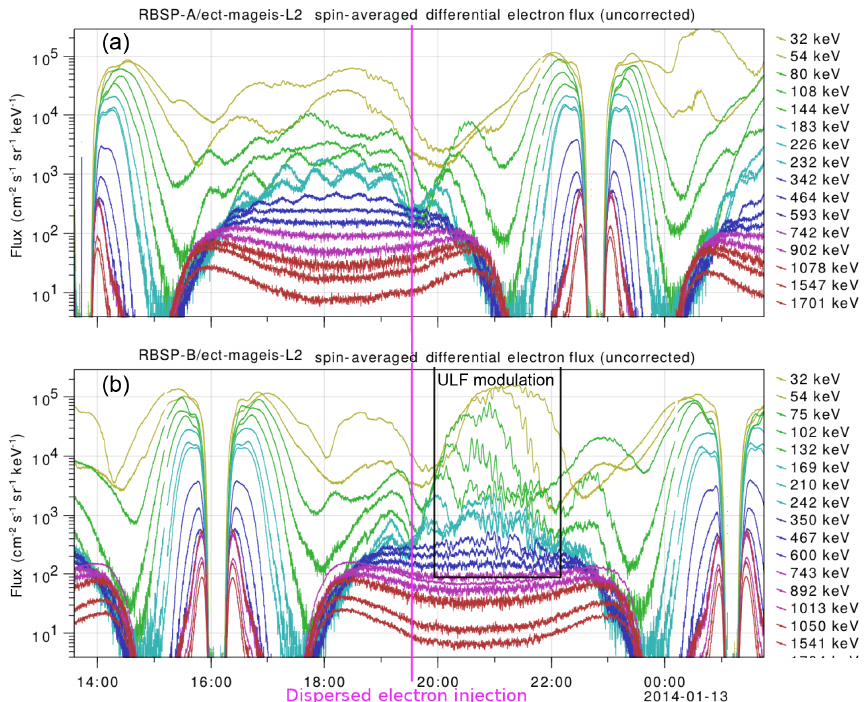
Figure 3. Variation of electron fluxes at different energies observed by Van Allen Probe A (a) and Van Allen Probe B (b) . In (b) , the modulation of electron fluxes was observed by Van Allen Probe B between 20:00:00 and 22:00:00UT in association with ULF waves, and the dispersed electron injection was observed at ∼